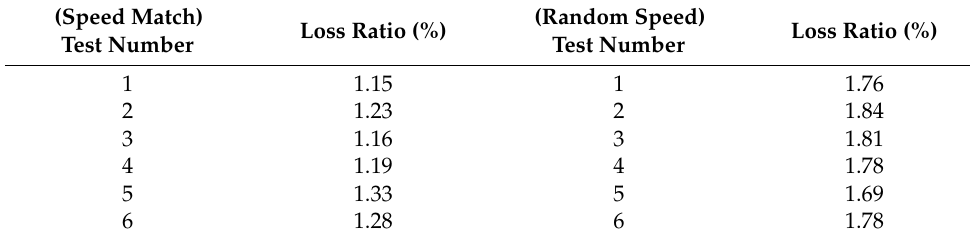
Table 9. The loss-rate table under matching grain speed and the loss-rate table under random rotary speed and forward